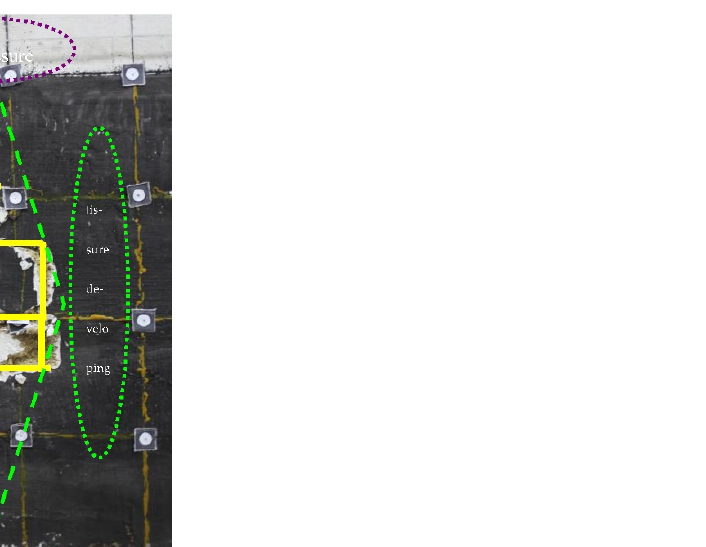
Figure 9. Development of joint and instability form the coal wall rib-spalling ( α = 60°).